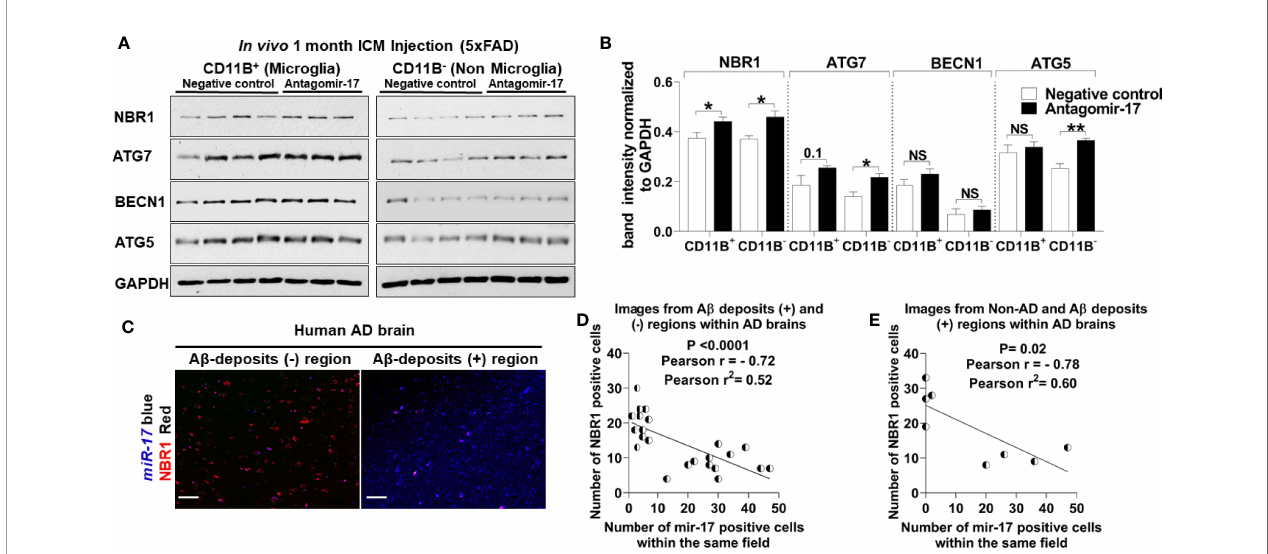
FIGURE 7 | The elevation of miR-17 expression is associated with decreased expression of NBR1 in mouse and human AD brain tissue. (A) NBR1, ATG7, BECN1, ATG5 and GAPDH immunoblot of primary microglia (CD11b + ) (left panel) and non-microglia (CD11b - ) (right panel) fractions of 2-month-old 5xFAD mice injected in their intracisterna magna (ICM) with 1.2 nmole of either antagomir-17 or non-target negative control once weekly for four weeks. (B) Densitometry analysis of immunoblots represented in (A) . Data represent mean ± SEM (n = 4 for negative control and 3 for antagomir-17). Statistical analysis was performed using unpaired two-tailed student ’ s t-test. (C) Representative images of the co-expression analysis of Immunohistochemistry of NBR1 (red) expression and in situ hybridization of miR-17 (blue) in A b deposits negative (-) and positive (+) area of AD brain tissue sections. Scale bar: 100µM. (D) Pearson correlation analysis of miR-17 and NBR1 expression in AD brains from the images represented in (C) (n = 4) (6 wide 20x fi eld images are taken per replicate in which 3 images are taken from A b deposits negative and 3 images from A b deposits positive). (E) Pearson correlation analysis of miR-17 and NBR1 expression in human brains (n = 8, 4 AD with A b deposits and 4 age matched no disease control) (1 wide 20x fi eld image are taken per n). *p ≤ 0.05, **p ≤ 0.01, NS, Not Signi fi